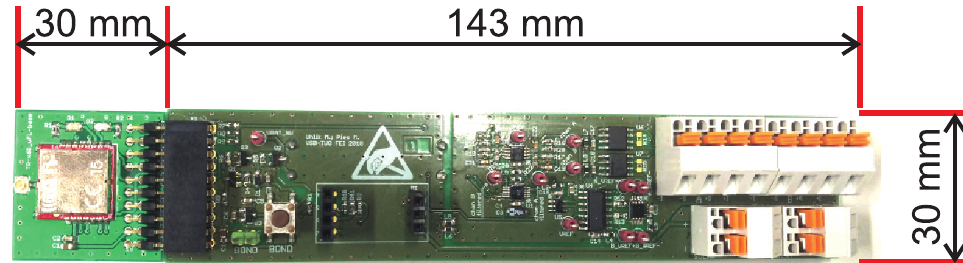
Figure 4. Internal structure of the load anchor cell wireless node developed by the authors.